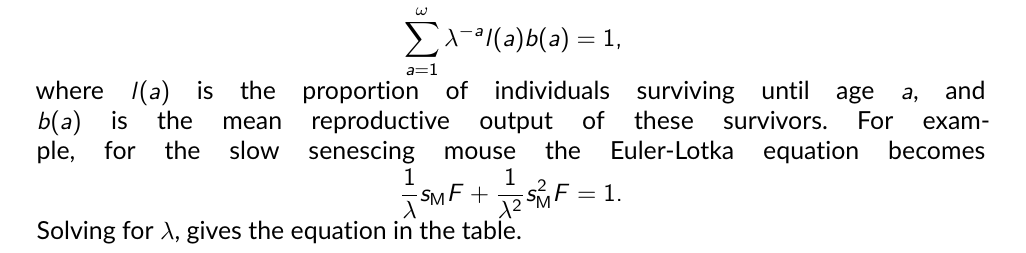
Table 1 – List of variables and their values used in the trade-off free example. To calculate λ , start from the Euler-Lotka equation for a species with ω age classes, ω